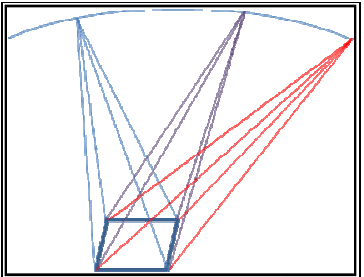
Fig. 1: Cartosat-2 Mult iview Imaging